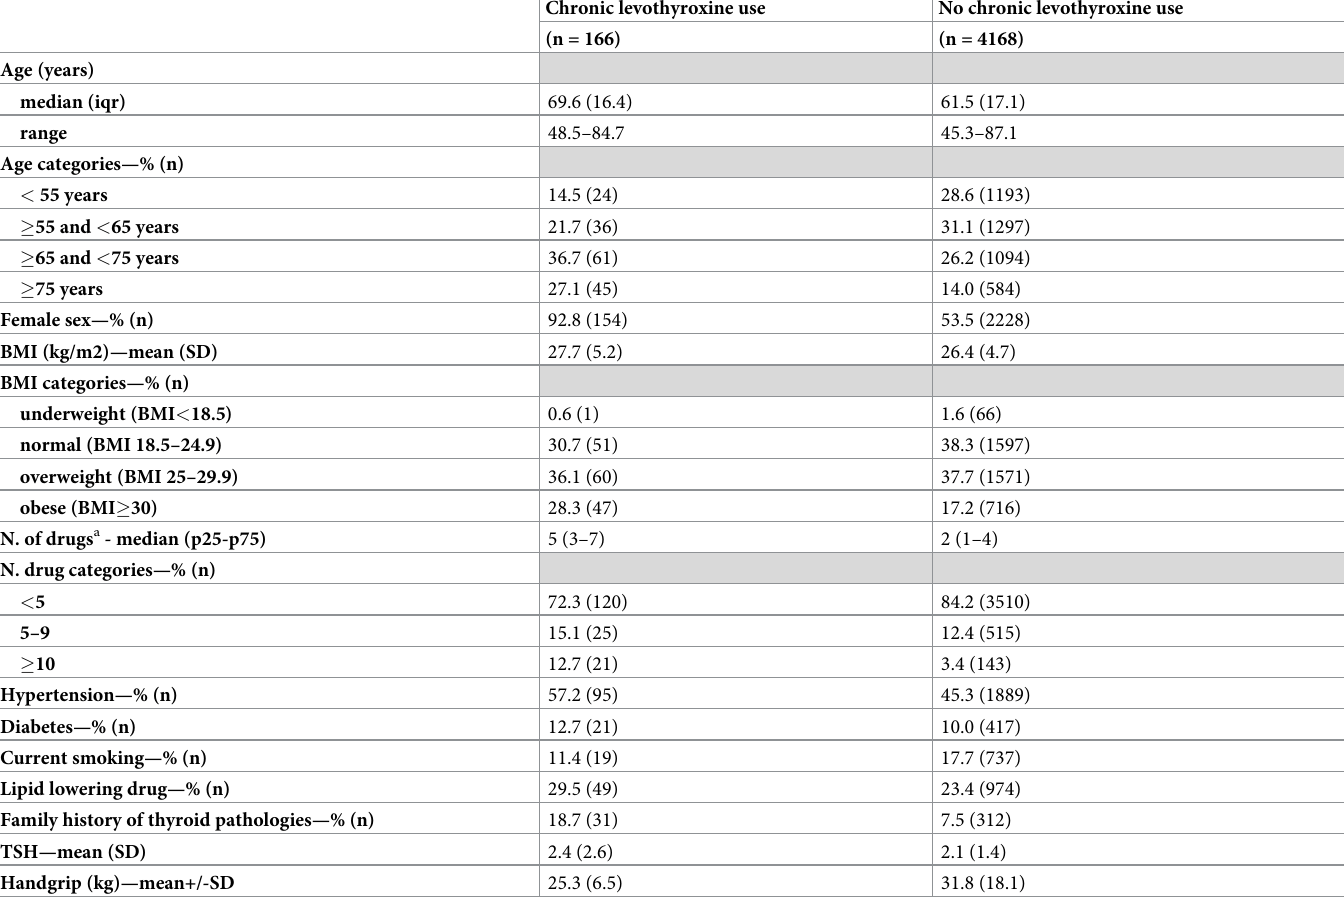
Table 3. Characteristics of participants with and without chronic levothyroxine